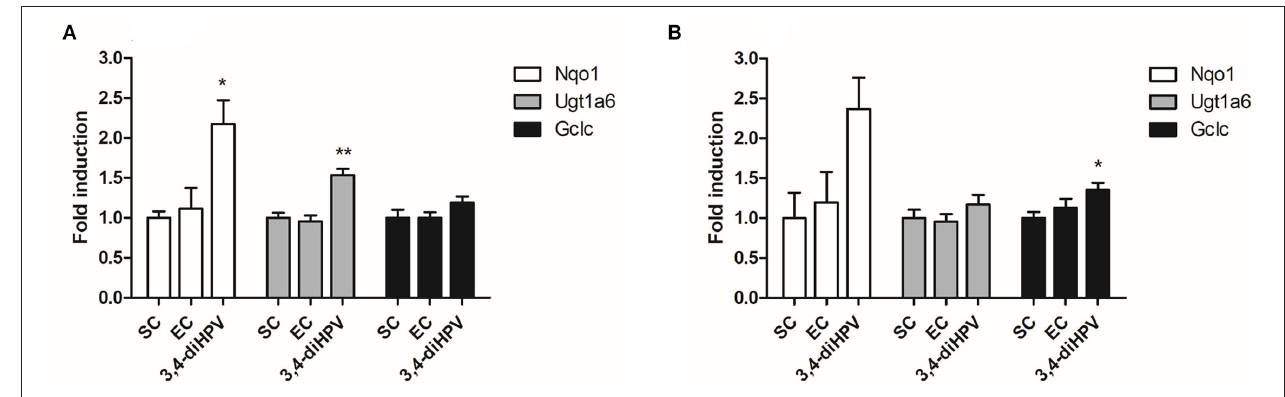
FIGURE 6 | Relative RNA (A) and protein (B) levels in Hepa1c1c7 cells after exposure to the EC or 3,4-diHPV at 30 µ M. Gene/protein names are depicted as figure legends. The results were calculated as the ratio of the treatment and the solvent control (SC) and are presented as mean ± SEM, derived from at least three independent experiments. Statistical differences between different treatments are demonstrated (* P < 0.05; ** P <